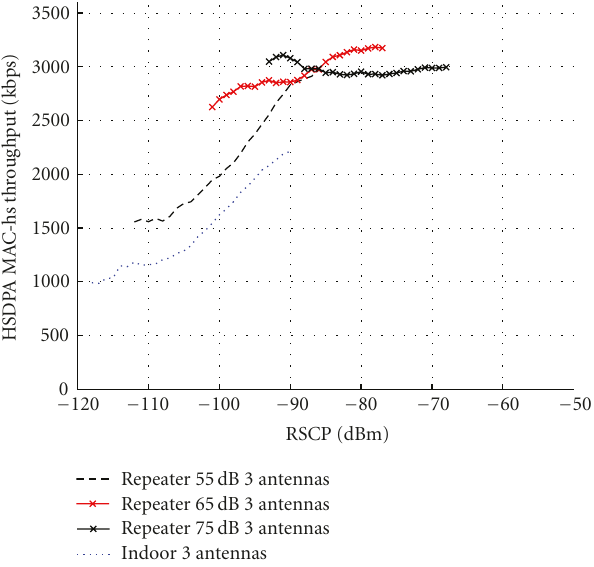
Figure 6: Average of all TP samples for each RSCP value, o ffi ce corridor. Repeater and indoor systems, 3 antenna configuration. Figure 7: Average of all TP samples for each RSCP value, open